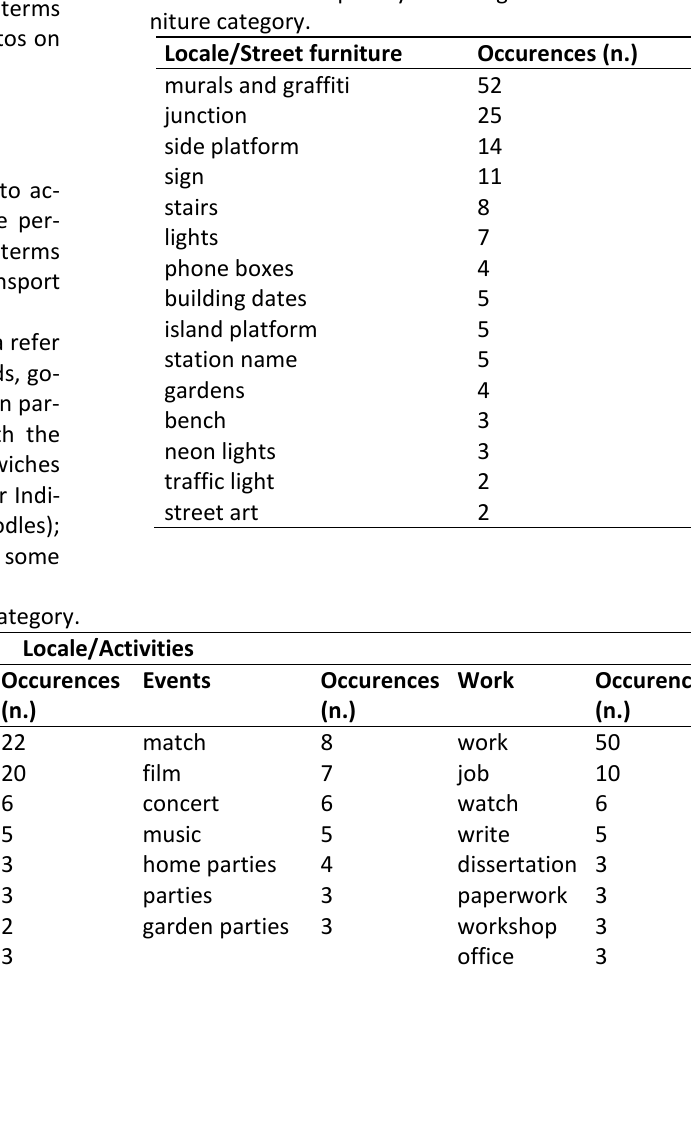
Table 4. Most frequently recurring terms in street fur- niture category.